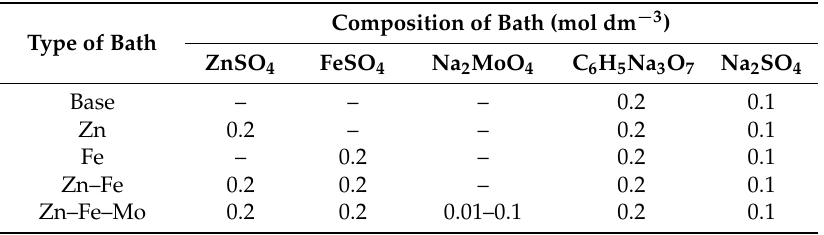
Table 1. Bath compositions used in this